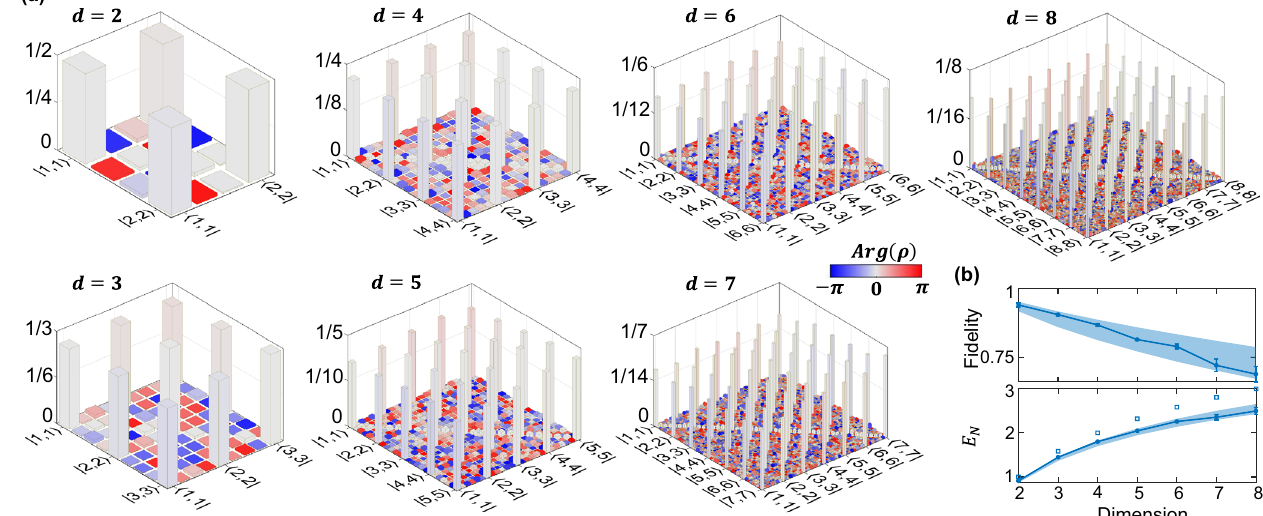
Fig. 4 | Tomography results for MRR BFCs and R =30 measurements. a Retrievedmeandensitymatricesfordimensionsupto d =8.Idealstates Ψ d plotted) are d -dimensional maximally entangled states with uniform phase. b Fidelities and log-negativities of retrieved density matrices (solid line). Shaded region corresponds to theoretically computed values for ρ λ (a mixture of a